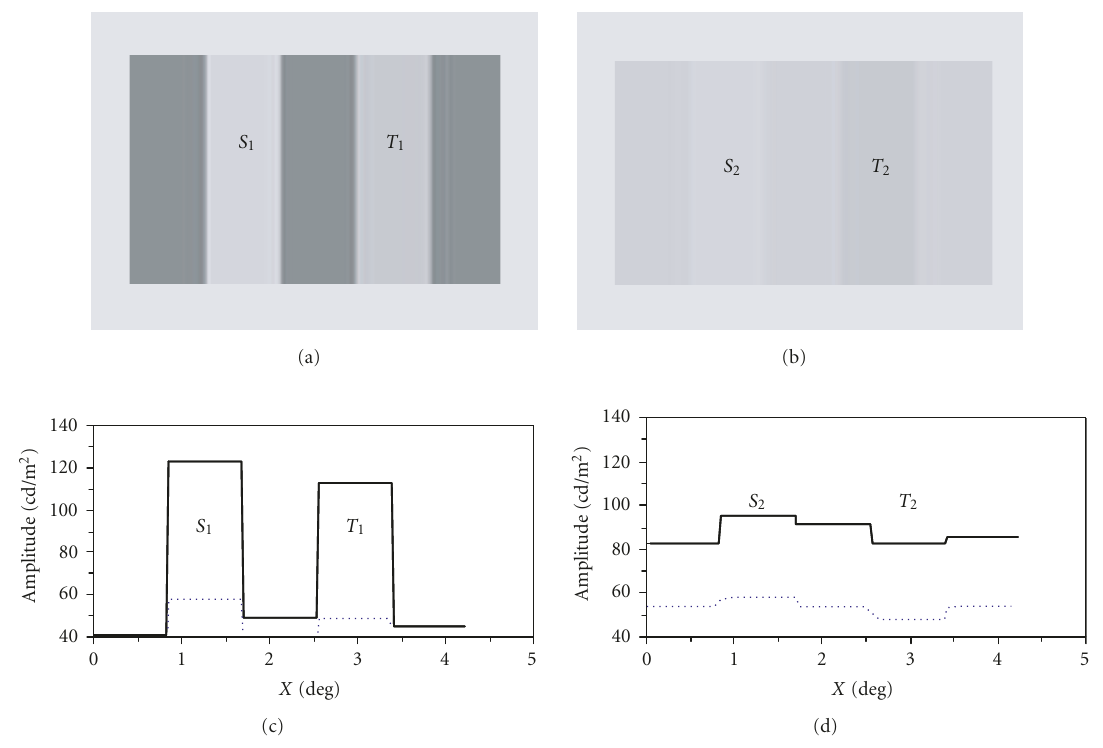
Figure 7: Stripes S 1 and S 2 have the same luminance of 57 cd/m2; stripes T 1 and T 2 have the same luminance of 48cd/m2; and the background luminance is 17cd/m2 for pattern A and 54cd/m2 for pattern B. Model predicted brightness for stripes S 1 and T 1 is 123 and 112 (thick lines of panel (c)), with a di ff erence of 11 units, and the predicted brightness for stripes S 2 and T 2 is 96 and 82 (thick lines of panel (d)), with a di ff erence of 14